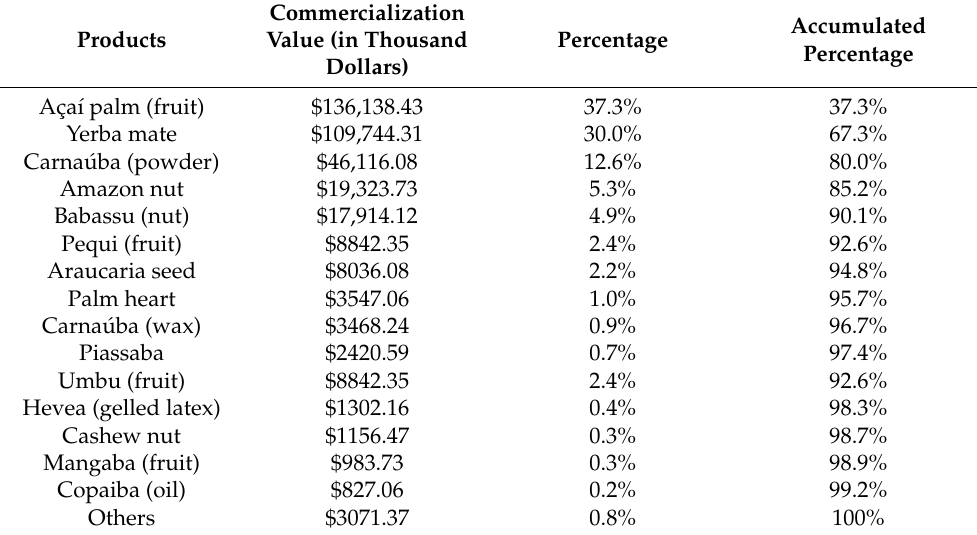
Table 2. Commercialization value (in thousand dollars) of NTFP production from natural forests in